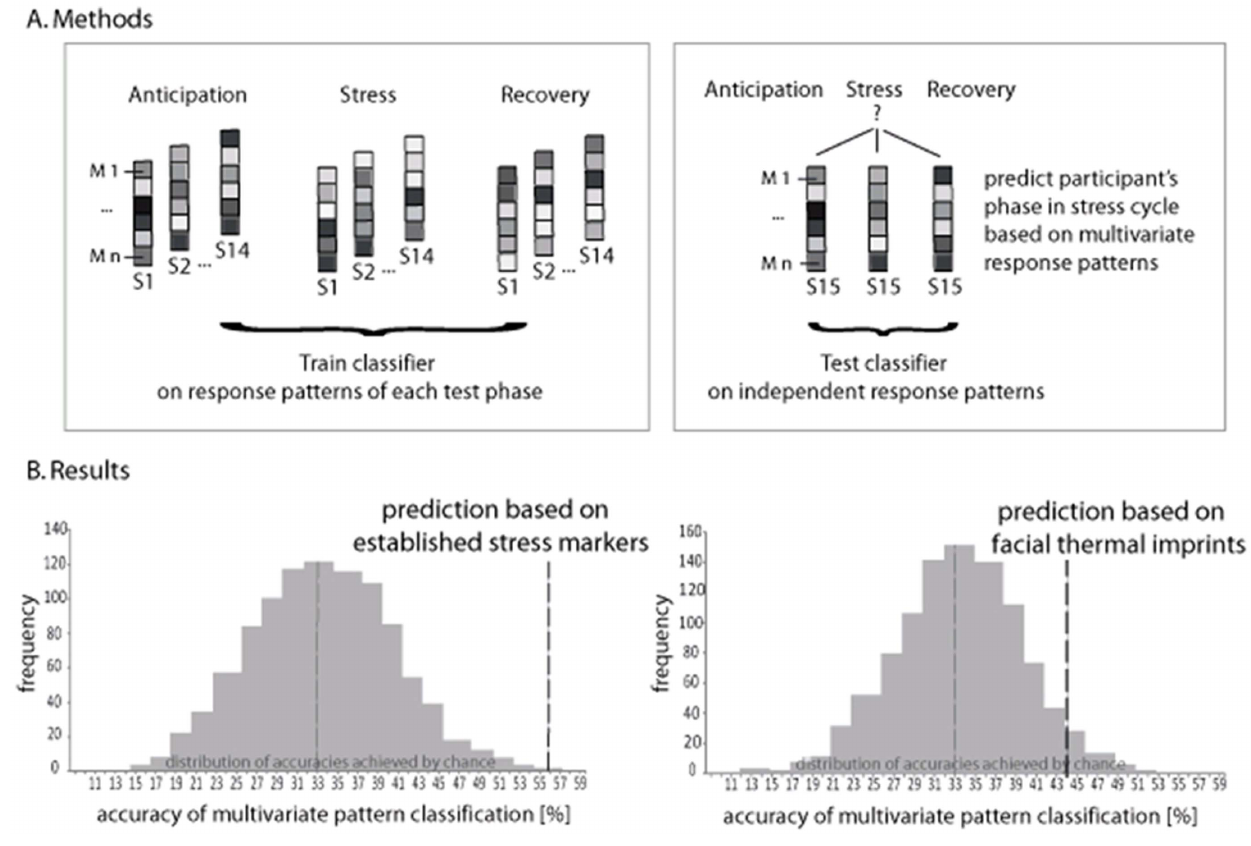
Figure 2. Multivariate pattern analysis of phases in the stress cycle. A Methods. For each subject (S 1…15 ), responses patterns were created that included the n measures (M) of either established stress markers or thermal imprints of a particular test phase (anticipation, stress, recovery). Response patterns of all but one subject were used to train a classifier to identify physiological response profiles that are characteristic for each of the test phases. This was the basis for the subsequent prediction of the response patterns of the remaining subject as belonging to either anticipation, stress of recovery phase. B Results. Multivariate response patterns of established stress measures obtained for the CPT (MVPA 1, left) reliably predicted the current test phase of a subject well above chance (56% classification accuracy, p , .001). Patterns of thermal facial imprints in the CPT (MVPA 2, right), on the other hand, did not significantly predict the correct phase (40% classification accuracy, p=.13). The histograms display the permutation distribution of classification accuracies achieved by chance (average